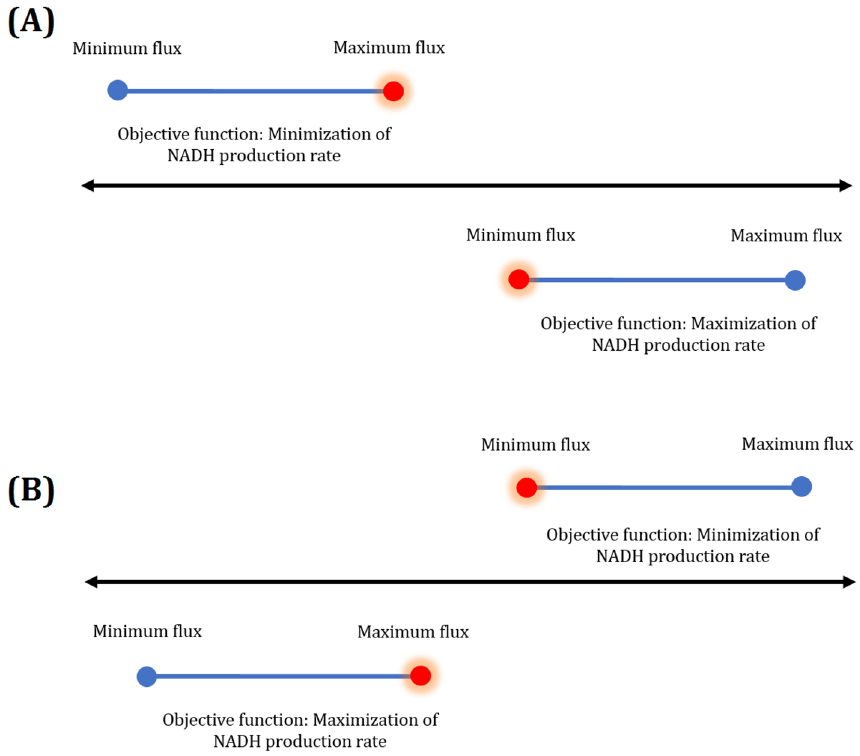
Figure 1. Comparison of flux variability for each reaction at the minimum and maximum rates of NADH production reaction to finding appropriate reactions for ( A ) up-regulation, and ( B ) down-regulation. Compared rates were highlighted in